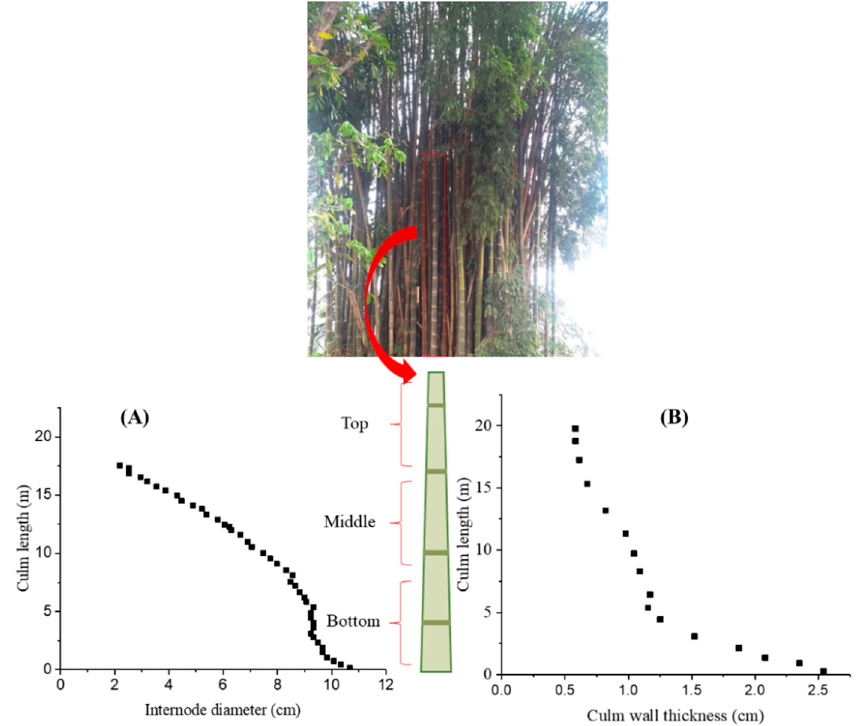
Figure 1. The variation of macroscopic characteristics along the culm length, an example of the bamboo species Dendrocalamus asper , ( A ) internode diameter and ( B ) culm wall thickness (data from [29]).